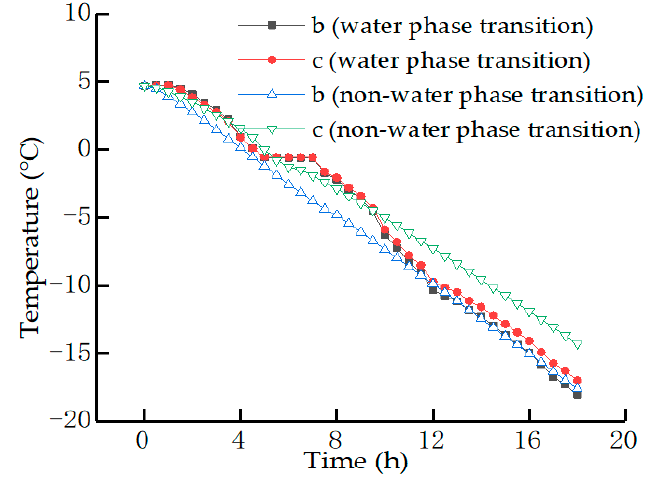
Figure 3. Varying characteristics of temperature with